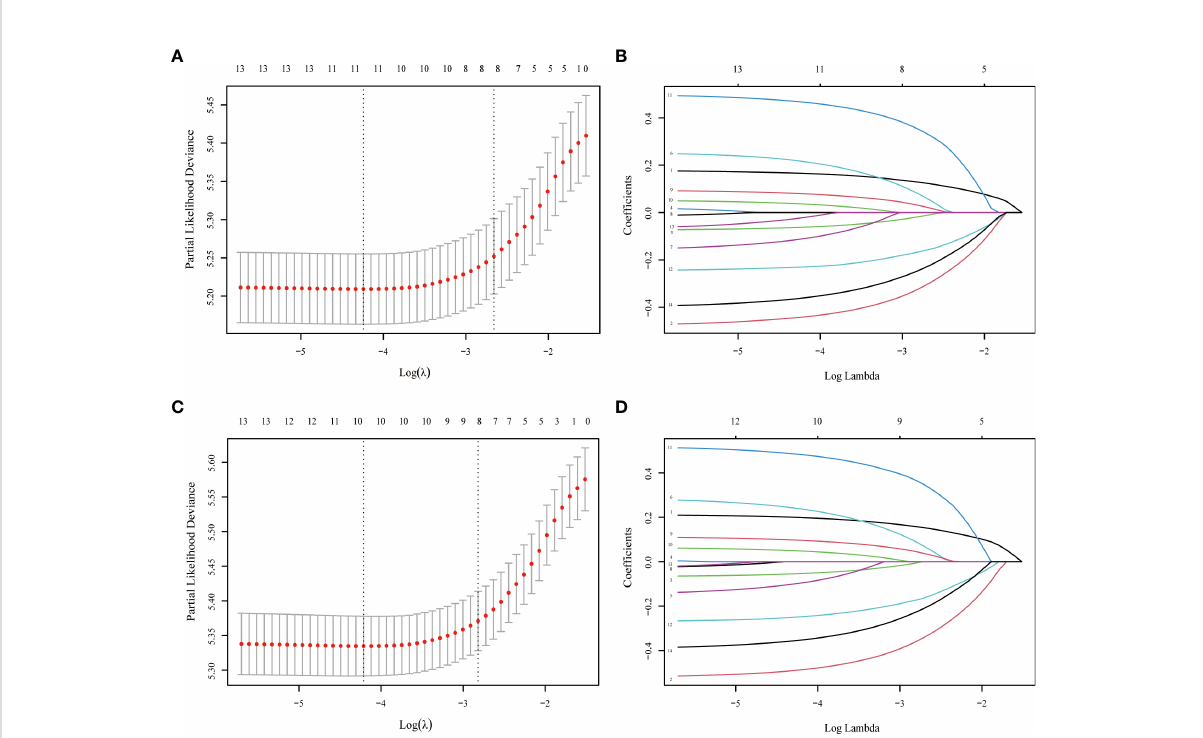
FIGURE 2 LASSO regression model was used to select characteristic impact factors for OS and CSS. Selection of tuning parameter ( l ) for the LASSO model in OS (A) and CSS (C) LASSO coef fi cients of fourteen features in OS (B) and CSS (D)